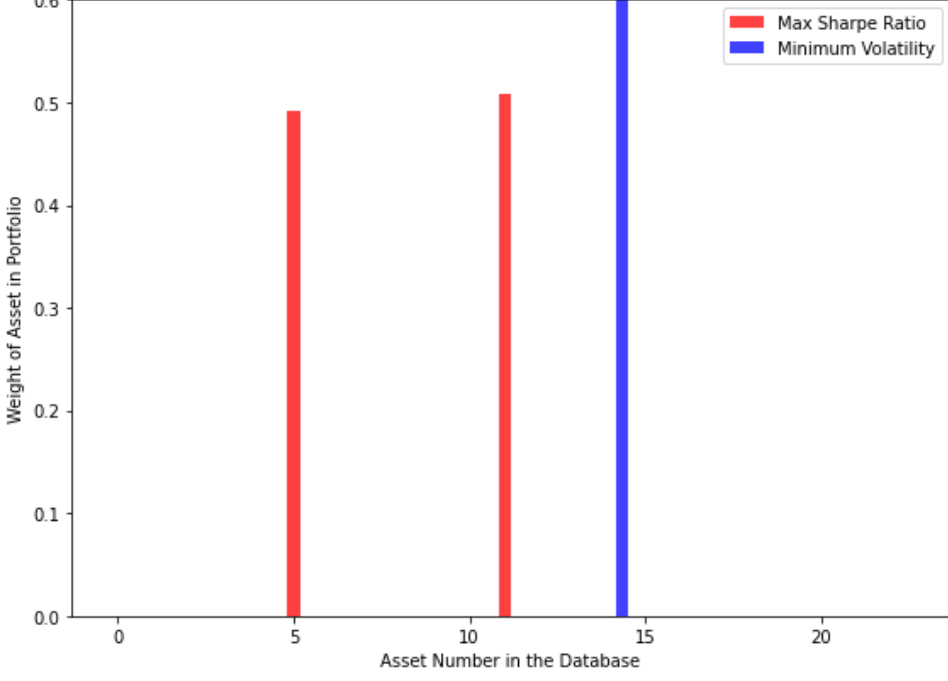
Figure 29. COVID-19 Wave III—Portfolio optimization: Weights and Sharpe